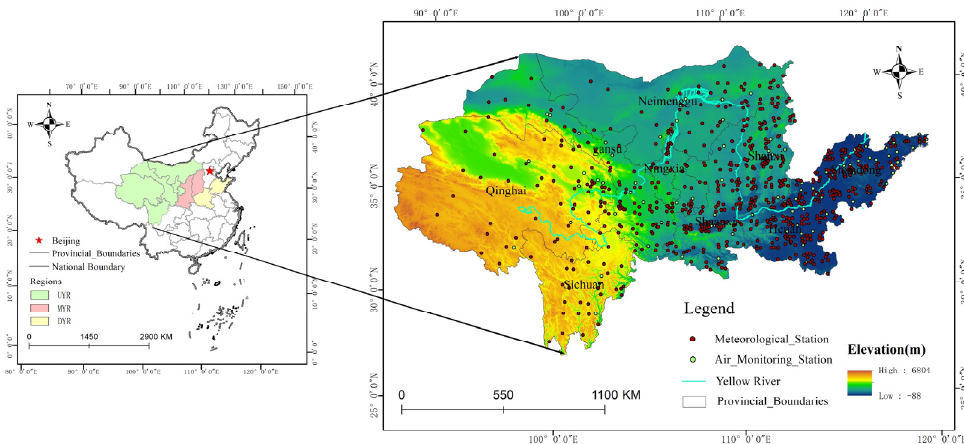
Figure 1. Overview of the Yellow River Basin in China. (YRB denotes the Yellow River Basin; UYR denotes the Upper Yellow River Basin; MYR denotes the Middle Yellow River Basin; DYR denotes the downstream area of the Yellow River Basin.)